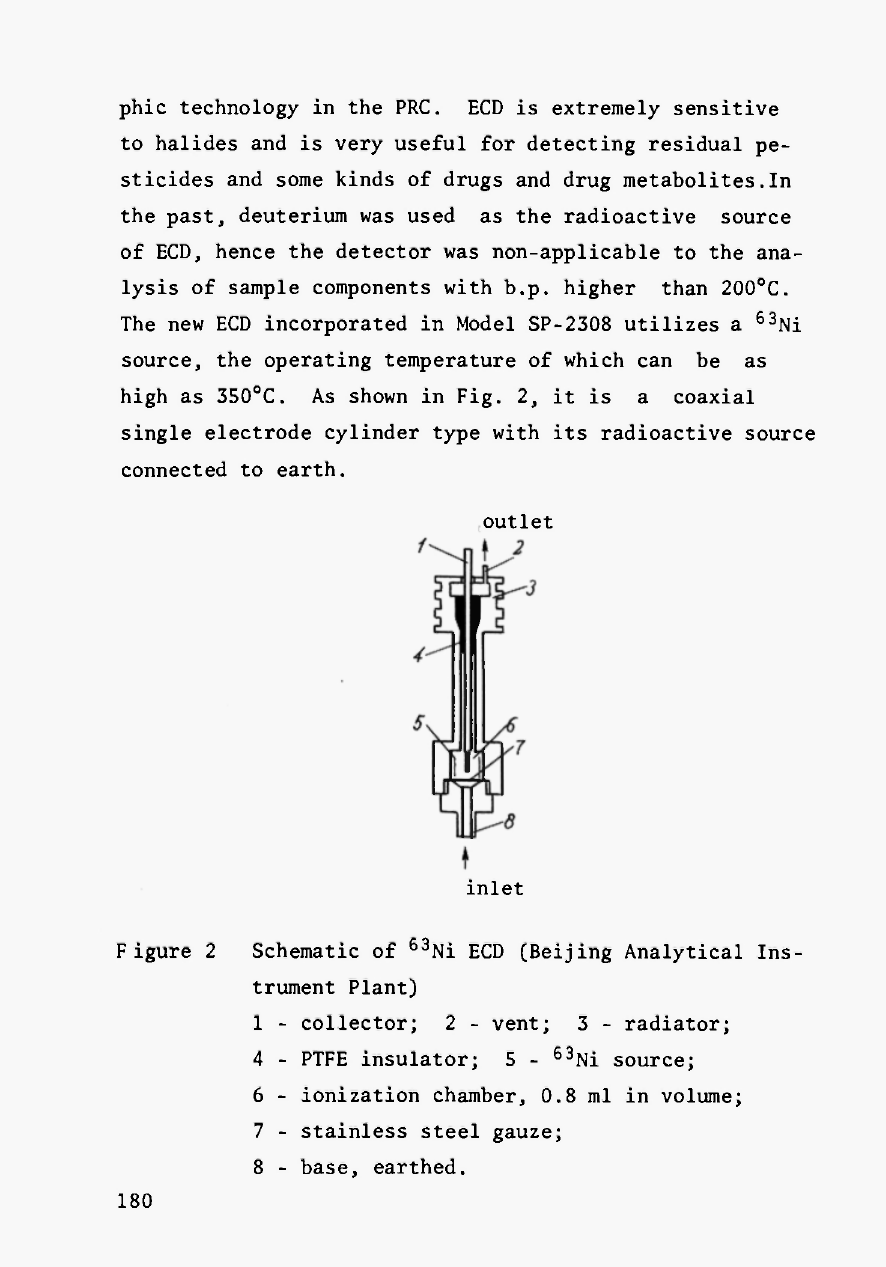
Figure 2 Schematic of 63 Ni ECD (Beijing Analytical Ins- trument